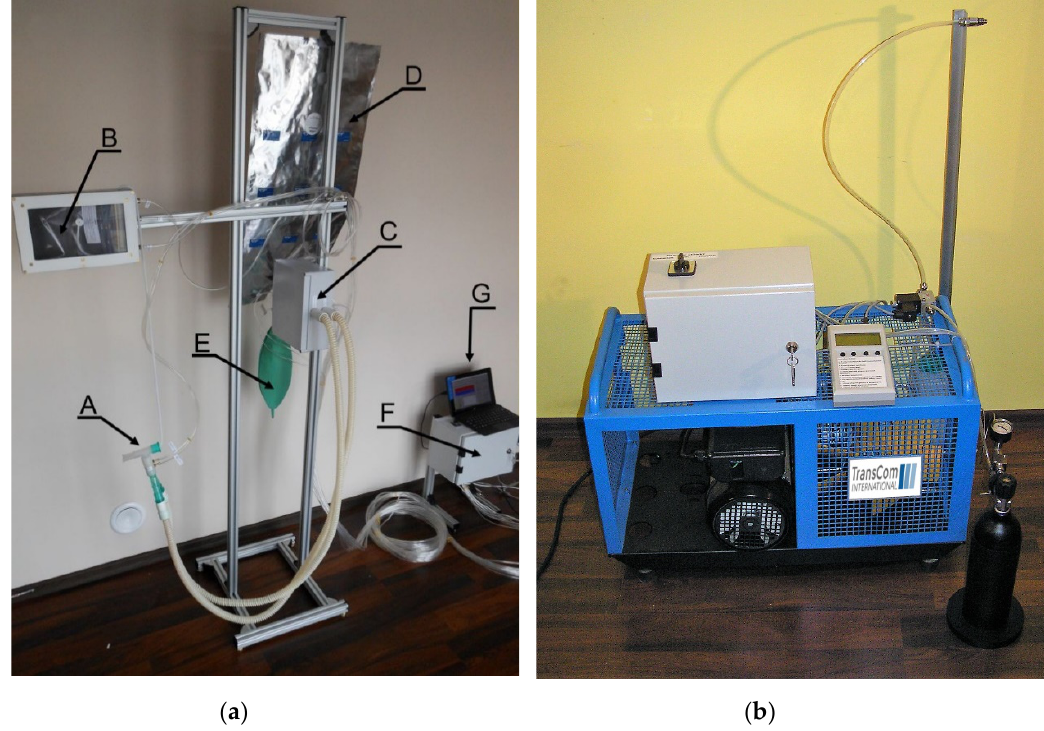
Figure 3. ( a ) Ventilator rack and ( b ) exhaled gas compression unit. The letters (A − G) denote the same as in Figure